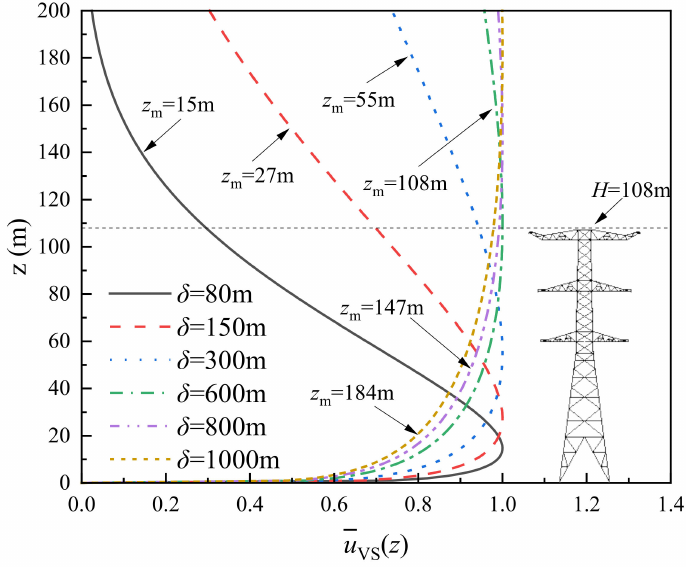
Figure 13. Variation of vertical wind profile of downburst with δ